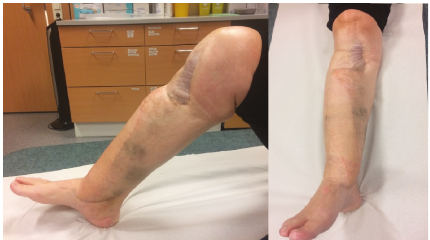
Figure 5: Patient ’ s right lower extremity image in an 8-year follow- up visit. The silver coating created a mild, local skin argyria pigmentation, with cosmetic